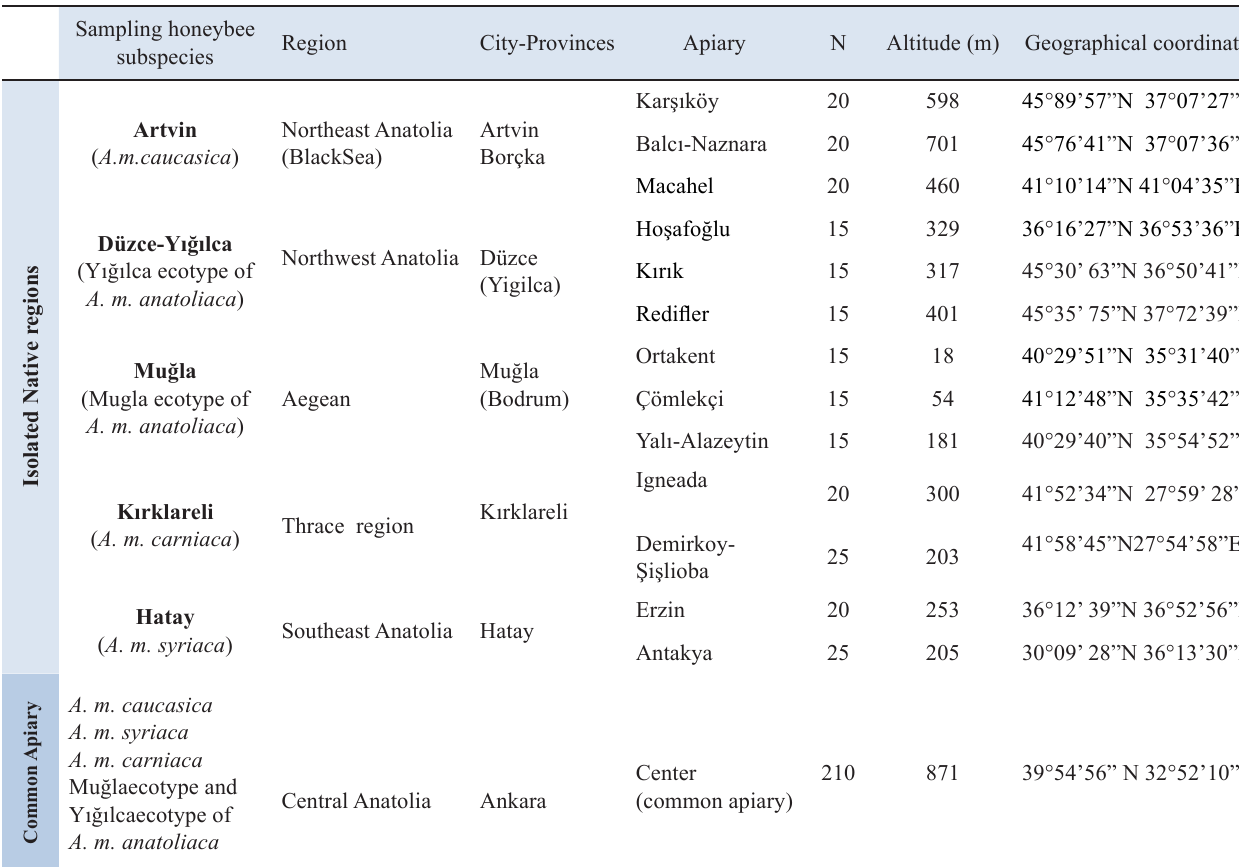
Table 1. Geographical coordinates of sampling locations. N = number of colonies sampled.